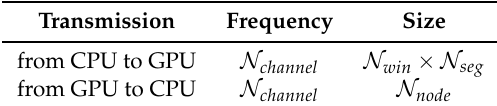
Table 2. Summarization of the frequency and transmission sizes between CPU and GPU for each feature with a duration of T bat if the number of concurrent clients is N channel , when using the baseline multichannel acoustic score